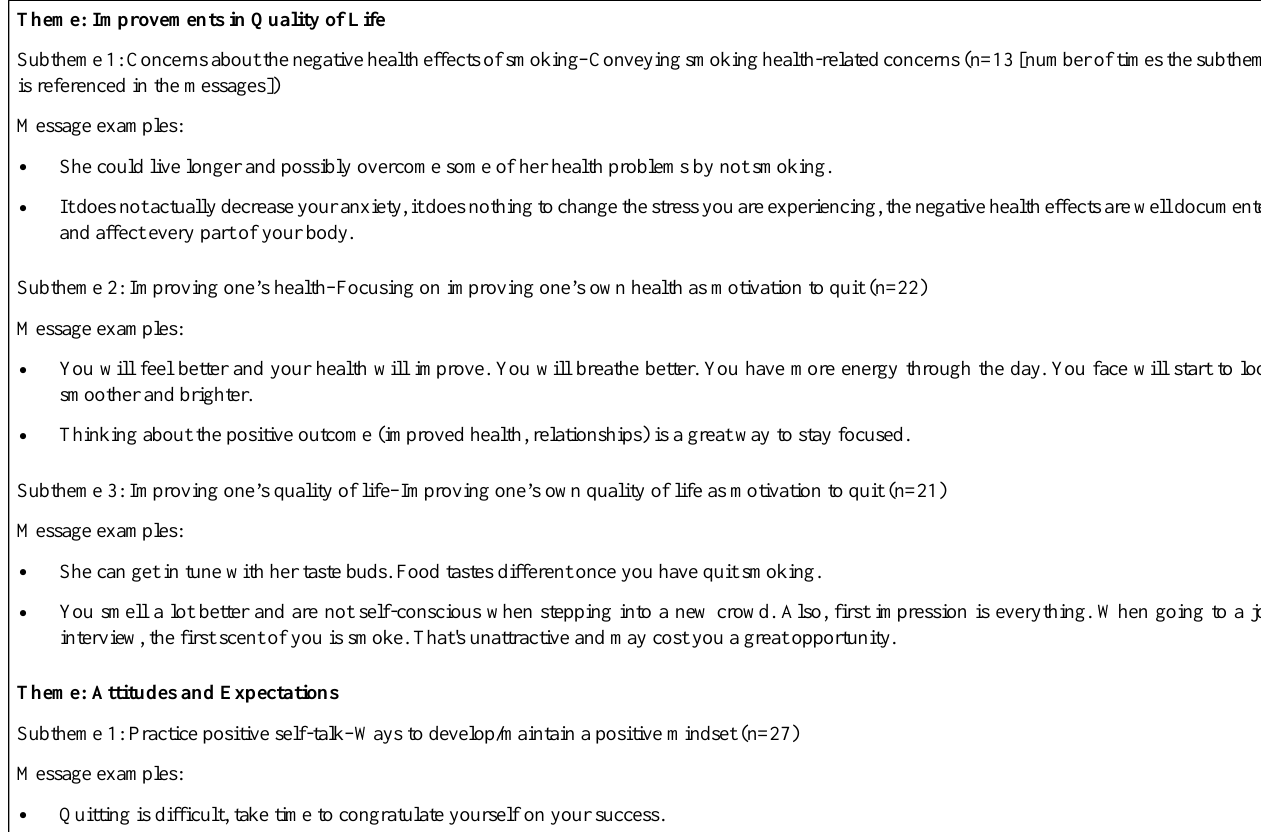
Textbox 2. Themes of improvements in quality of life, attitudes and expectations, and mindfulness/religious or spiritual practices, and their subthemes derived from messages (N=318) written by African American smokers who participated in our online